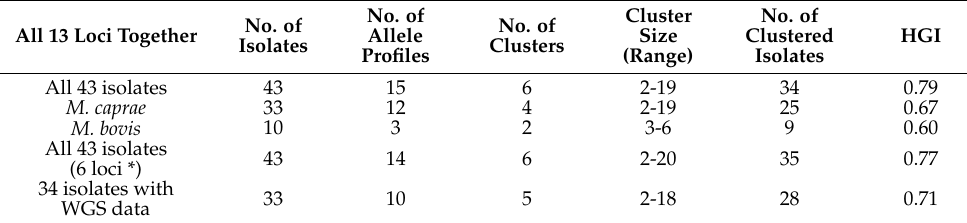
Table 3. Clustering of M. bovis / M. caprae isolates based on the different number of loci. No. of Cluster No. of No. of HGI All 13 Loci Together No. of Isolates Allele Size Clustered Clusters Profiles (Range) Isolates All 43 isolates 43 15 6 2-19 34 0.79 M. caprae 33 12 2-19 43 0.77 (6 loci *) 33 10 5 2-18 28